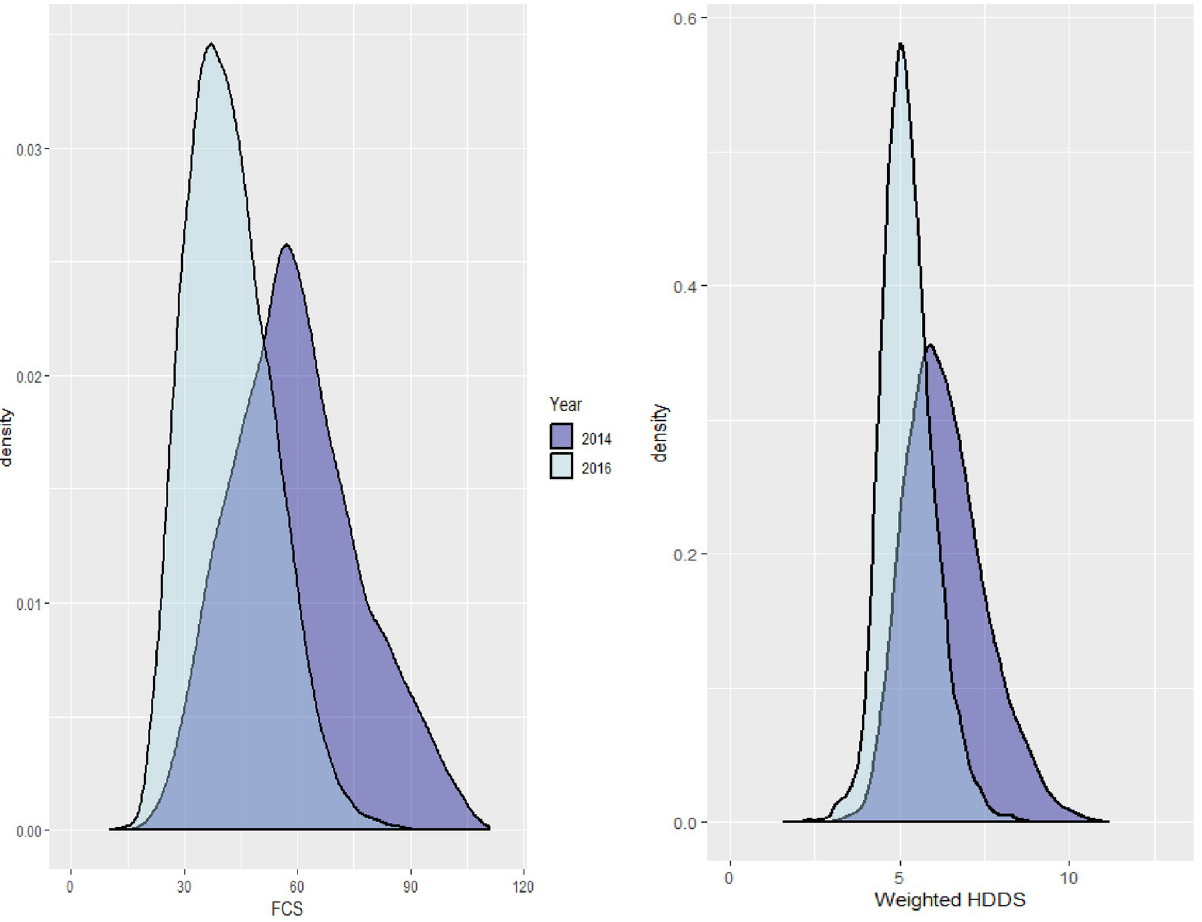
Fig 7. Simulated FCS and weighted HDDS densities from fitted models for Hadramout in 2014 and 2016.